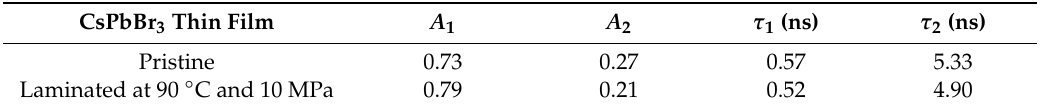
Table 2. Summary of the photodynamic parameters of pristine CsPbBr 3 thin film and the film laminated at 90 ◦ C and 10